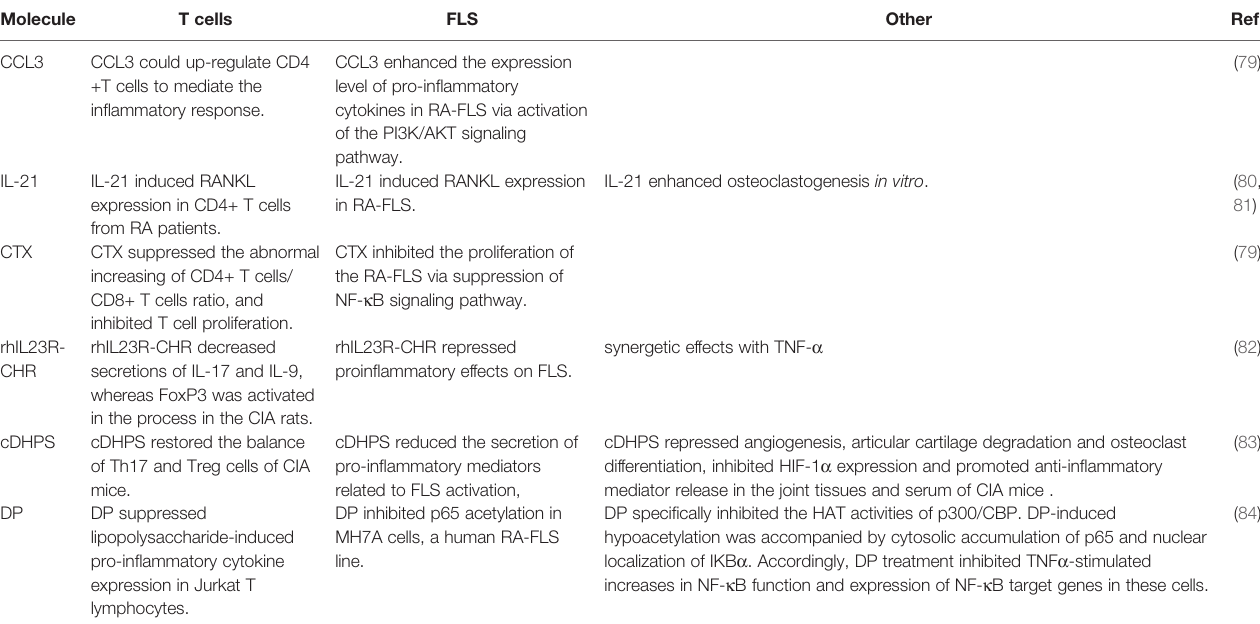
TABLE 2 | Speci fi c gene/protein that can affect the functions of both T cells and FLS in RA. Molecule T cells FLS Other Ref CCL3 CCL3 could up-regulate CD4 +T cells to mediate the in fl ammatory